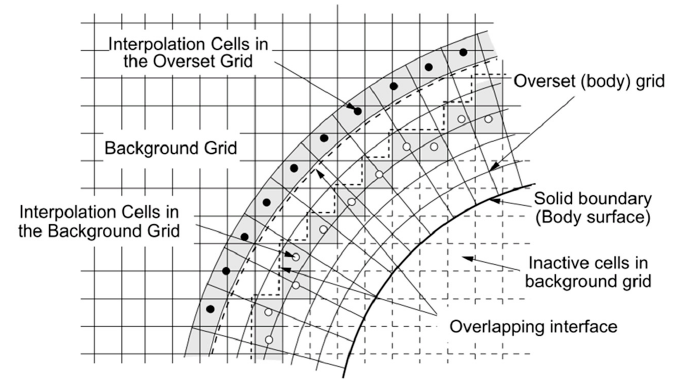
Figure 4. A detailed view of the overlap region with some definitions and notations [16].